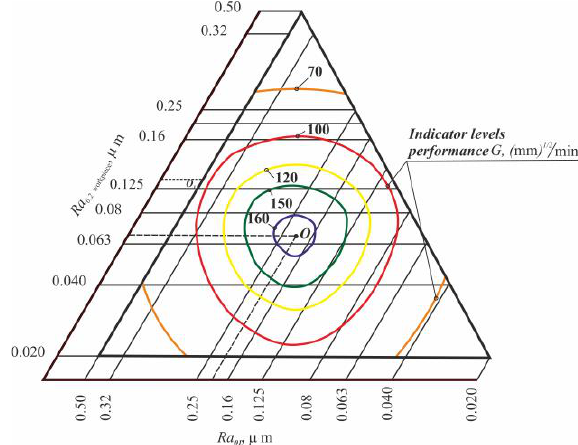
Figure 7. The dependence of the productivity indicator on the surface roughness after the first and second finishing operations when grinding parts in three operations to obtain: Ra 0 = 0.50 µ m; Ra 1 = 0.025 µ m; V K = 35 m · s − 1